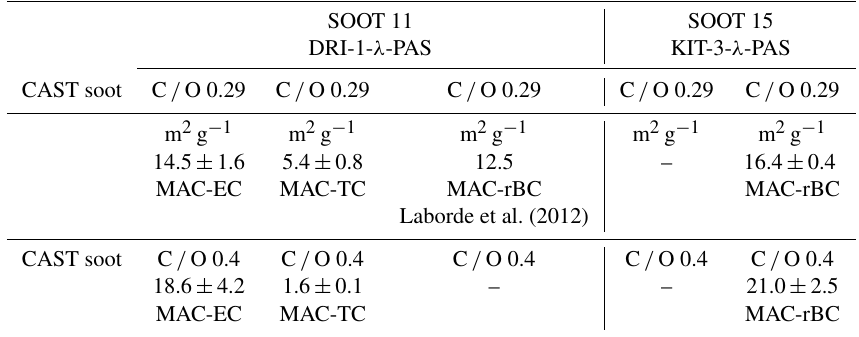
Table 1. Comparison of MAC determined at 532nm during two campaigns – the method-specific carbonaceous mass that the MAC is related to is given by the abbreviations EC and TC (Sunset) as well as rBC